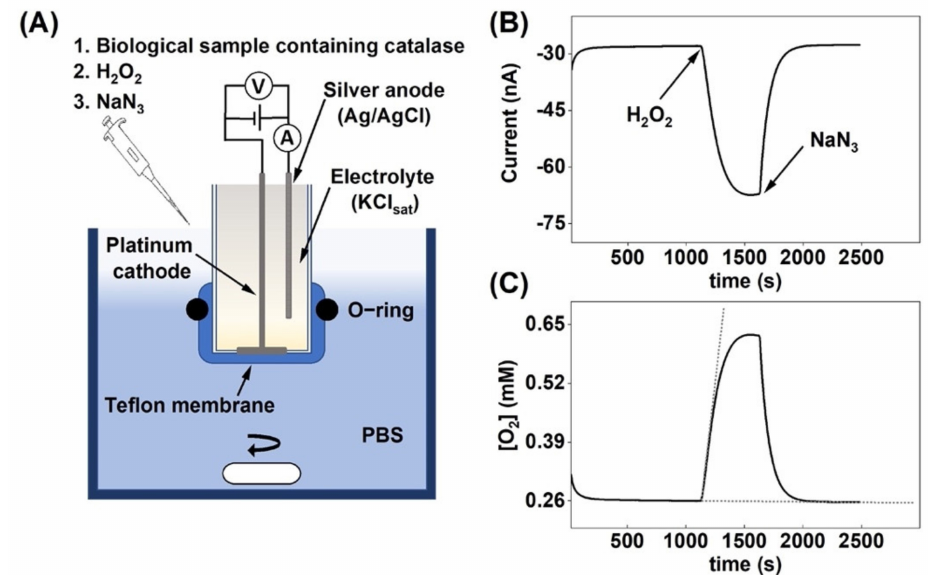
Figure 1. ( A ) Schematic illustration of the oxygen electrode set-up and the experimental protocol used to measure the change in oxygen concentration due to H 2 O 2 decomposition by catalase. The electrode is immersed in glass reaction vessel filled with 5 mL of PBS, which is kept under continuous stirring. ( B ) Current response due to oxygen production after H 2 O 2 addition followed by catalase inhibition by sodium azide. ( C ) Change of the O 2 concentration in the reaction vessel, corresponding to the current response in ( B ). The dashed lines illustrate the tangents used to determine the initial reaction velocity d [ O 2 ] / dt , see Equation